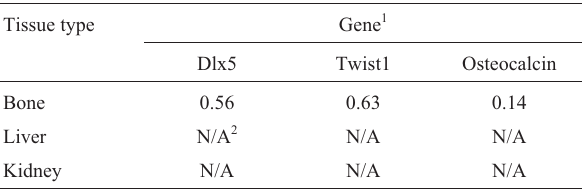
Table 4 - Bone-specific gene expression in different tissues evaluated by microarray analysis.